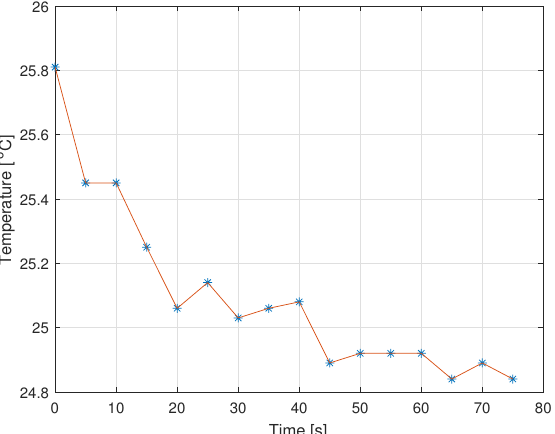
Figure 4. Examples of time trends of the temperature in points: (2— top ) and (4— bottom